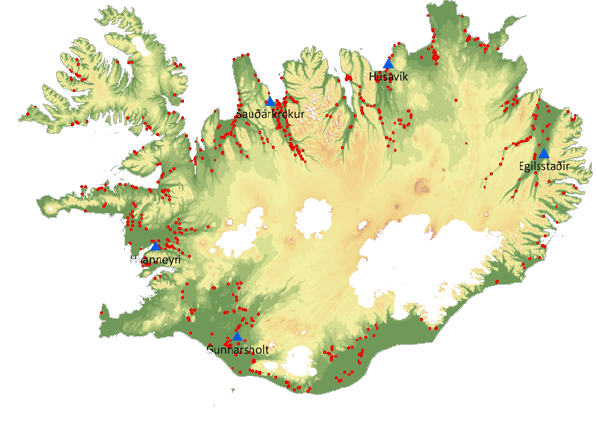
Fig. 1 . Map of Iceland showing location of farms participating in the Farmers Heal the Land project 2011 (red dots) and district offices of the Soil Conservation Service of Iceland (blue triangles) (S. J. Brynleifsdóttir, Soil Conservation Service of Iceland